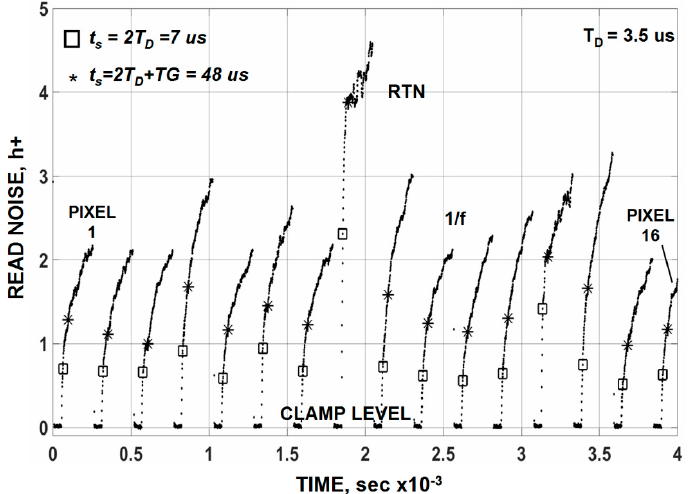
Figure 13. Measured noise for the raw clamped video in Figure 12. The “square” points represent the ideal sampling time after clamp is released ( i.e. , t s = 2 τ D ). The “star” points include TG overhead and settling time.